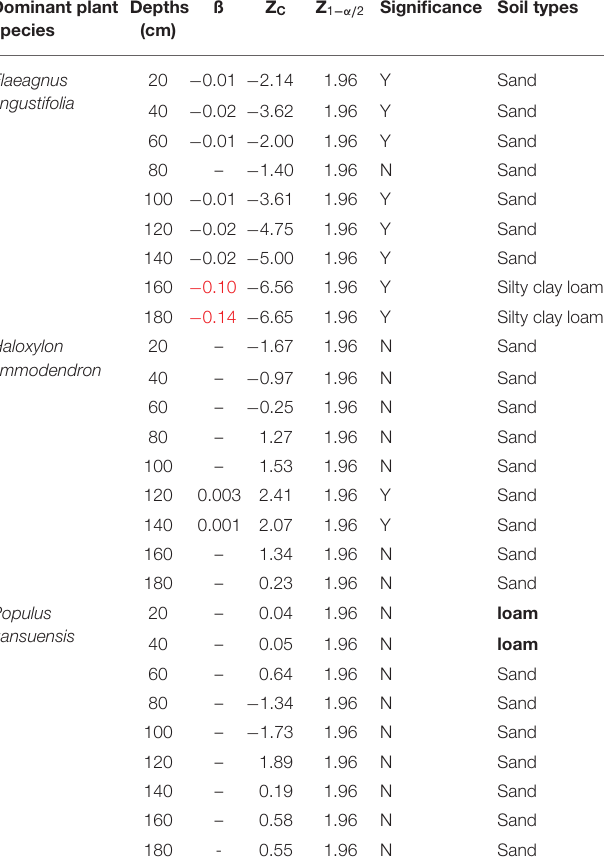
TABLE 2 | Mann–Kendall test and field trends of soil water content in shrubland (red represents sharp decrease rate of soil water content). Dominant plant species